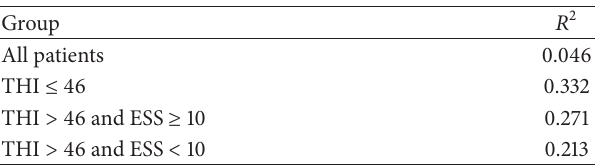
Table 4: Correlation coefficients for Tinnitus Handicap Inventory (THI) total score and Epworth Sleepiness Scale score.